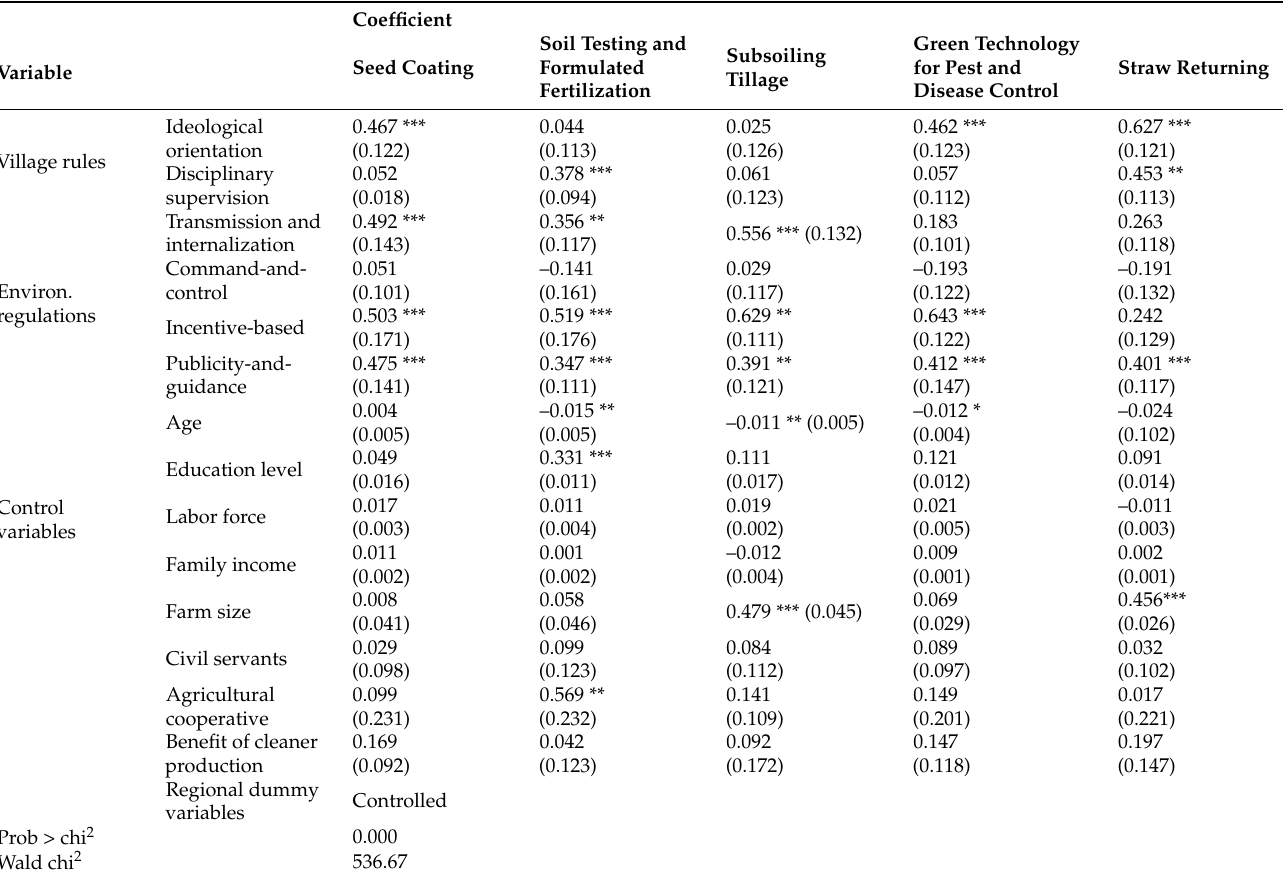
Table 2. Regression results of multivariate probit model (model